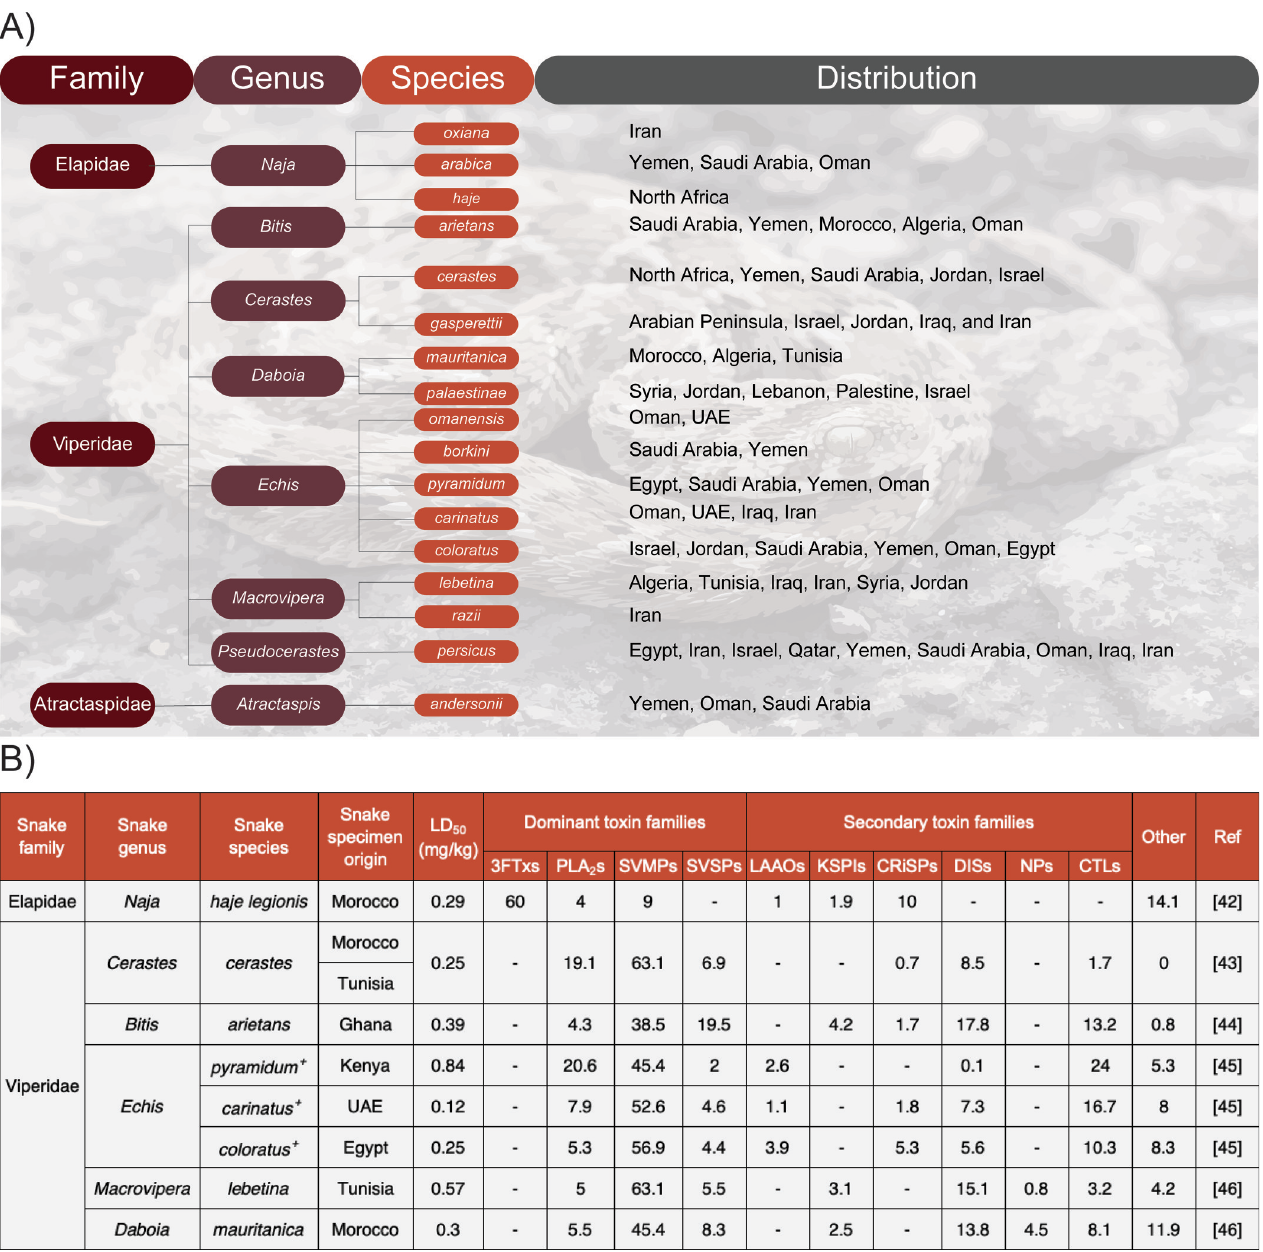
or synthesized from mRNAs that have lost their metalloprotease-coding region [38]. DISs induce their toxicity through interacting with integrins on platelets, which are responsible for cell–ECM interactions and intercellular signaling [39], hence interfering with clot formation.